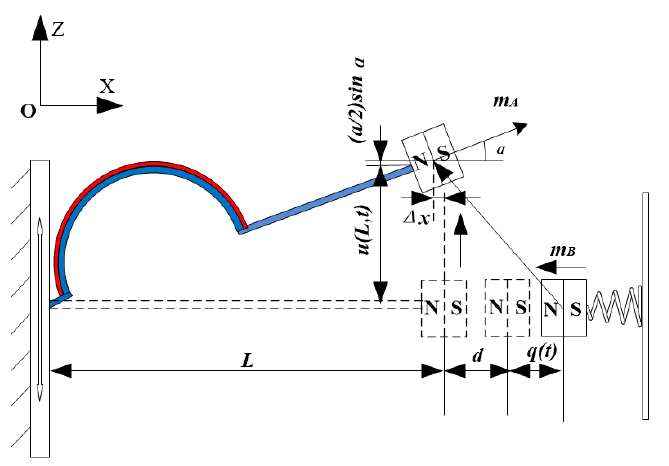
Figure 6. Schematic diagram of the spatial position of the